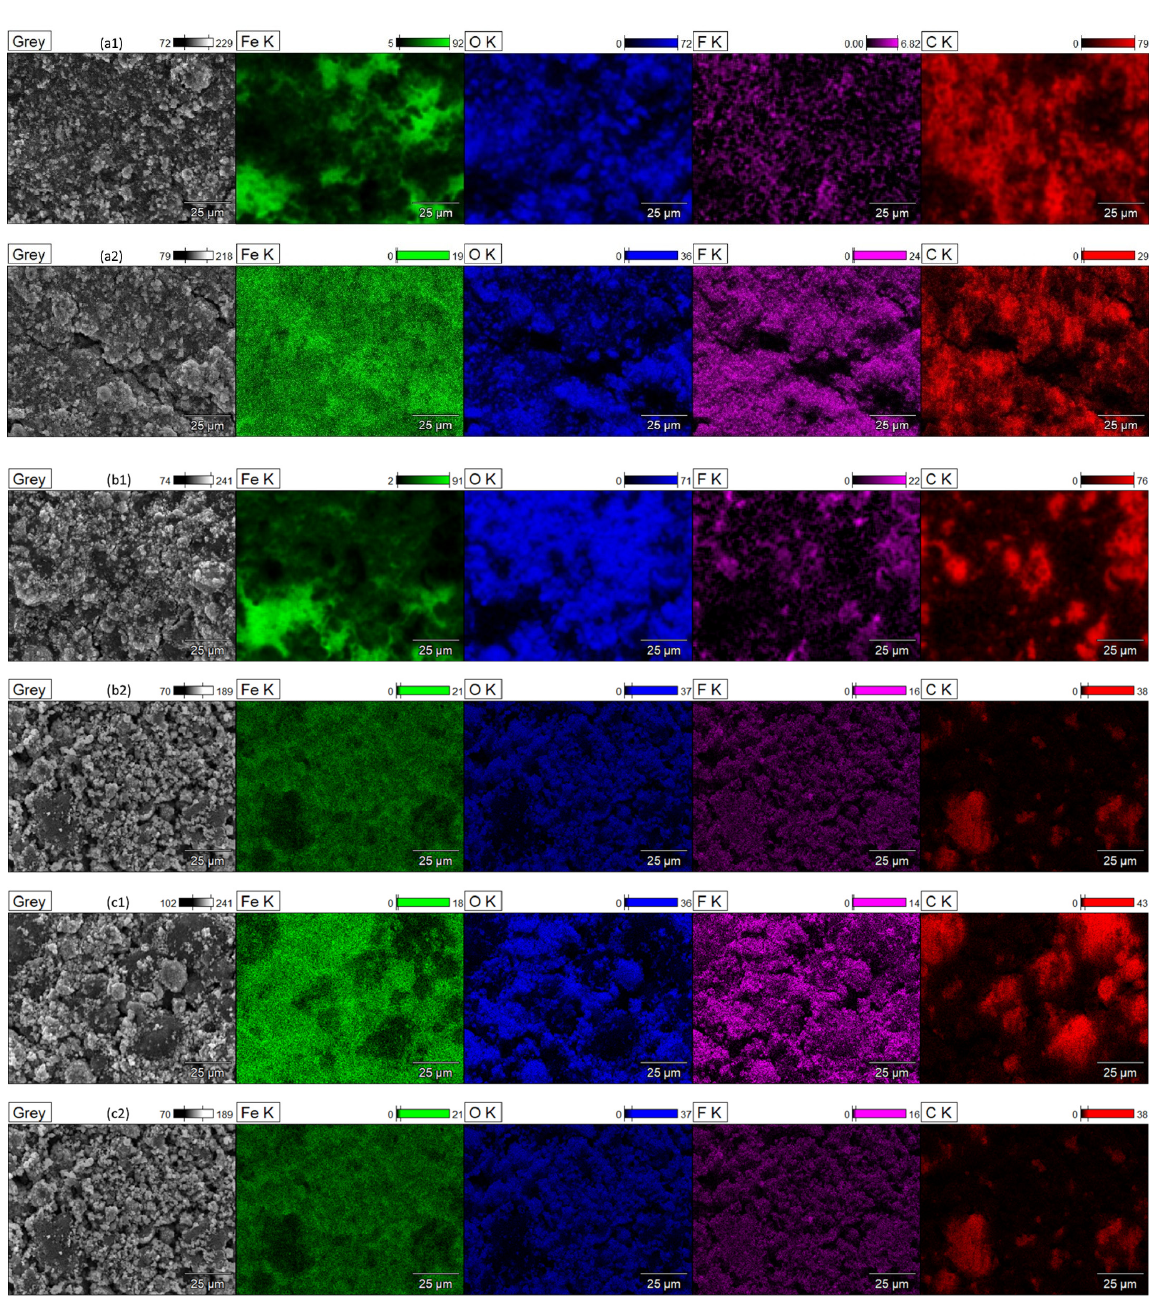
Figure 6. SEM/EDX maps (15 kV) of coatings as prepared (second index: 1) and postmortem after 25 battery cell cycles (second index: 2). First index: ( a ): PVDF binder; ( b ): KynarFlex ® PVDF 2801-00 binder; ( c ): Kynar PowerFlex ® LBG binder.